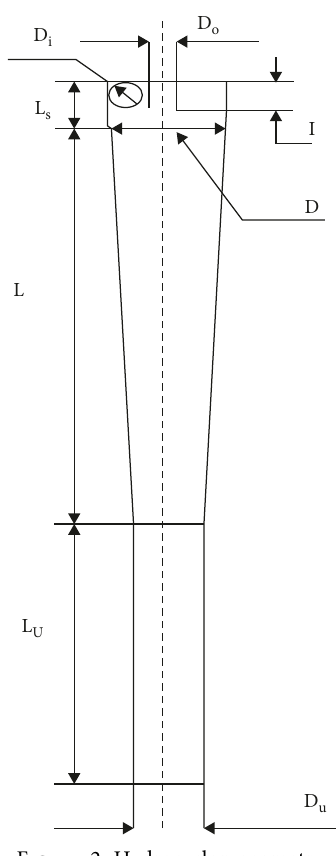
Figure 2: Hydrocyclon